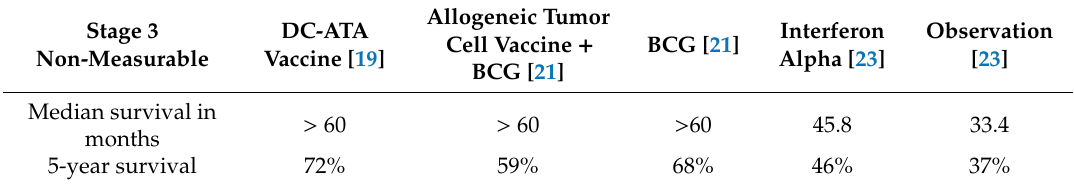
Table 1. Survival associated with immunotherapies for patients with stage 3 melanoma, but no measurable disease at the time of treatment.